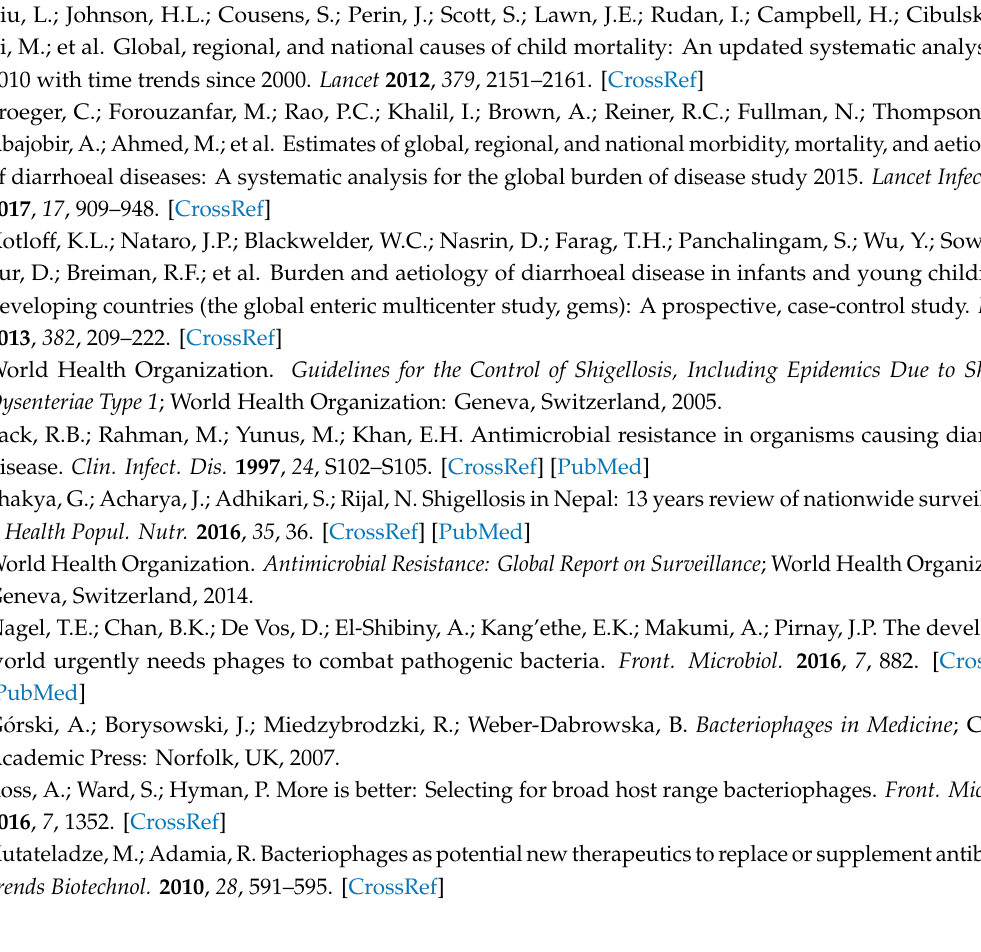
Figure S1: SDS-PAGE analysis of JK16 proteome, Table S1: Putative functions of CM1 tail structural proteins based on HHpred analysis, Table S2: Genes and predicted gene products (predicted by HMMER and BLASTp analysis) of the novel phage JK16 and S3, Table S3: Putative functions of a few of the JK16 tail structural proteins. Author Contributions: Planning and performing the majority of experiments, J.K. and E.C.; TEM, H.N.